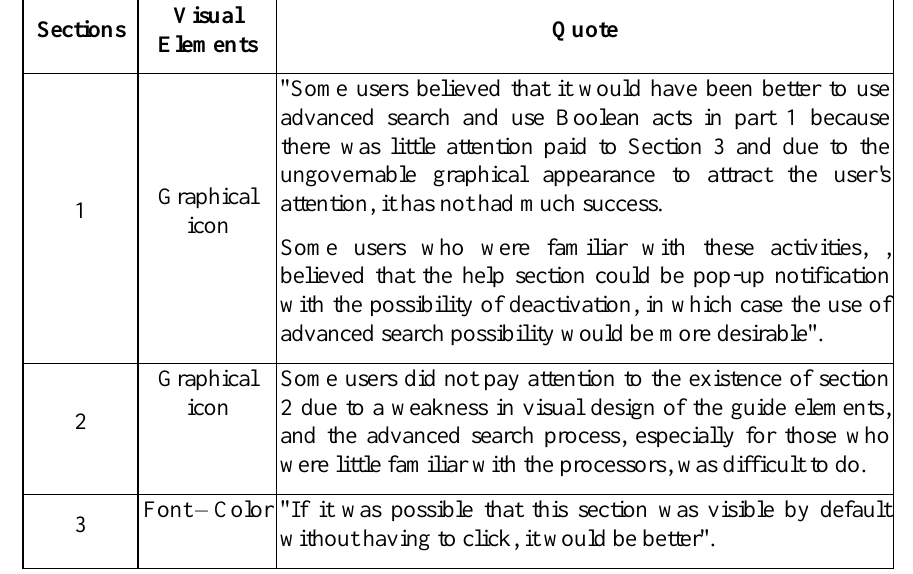
Table 4 - Elements of interest to users on the search